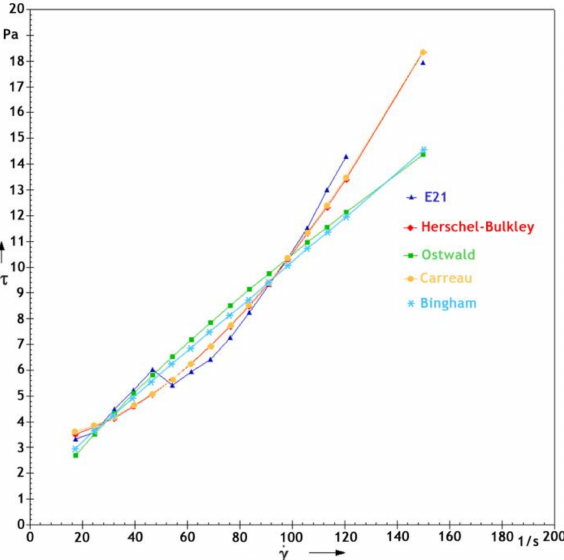
Figure 6. Flow curves for alloy E21: actual and computed from the Hershel-Bulkley ( R 2 = 0.9861),